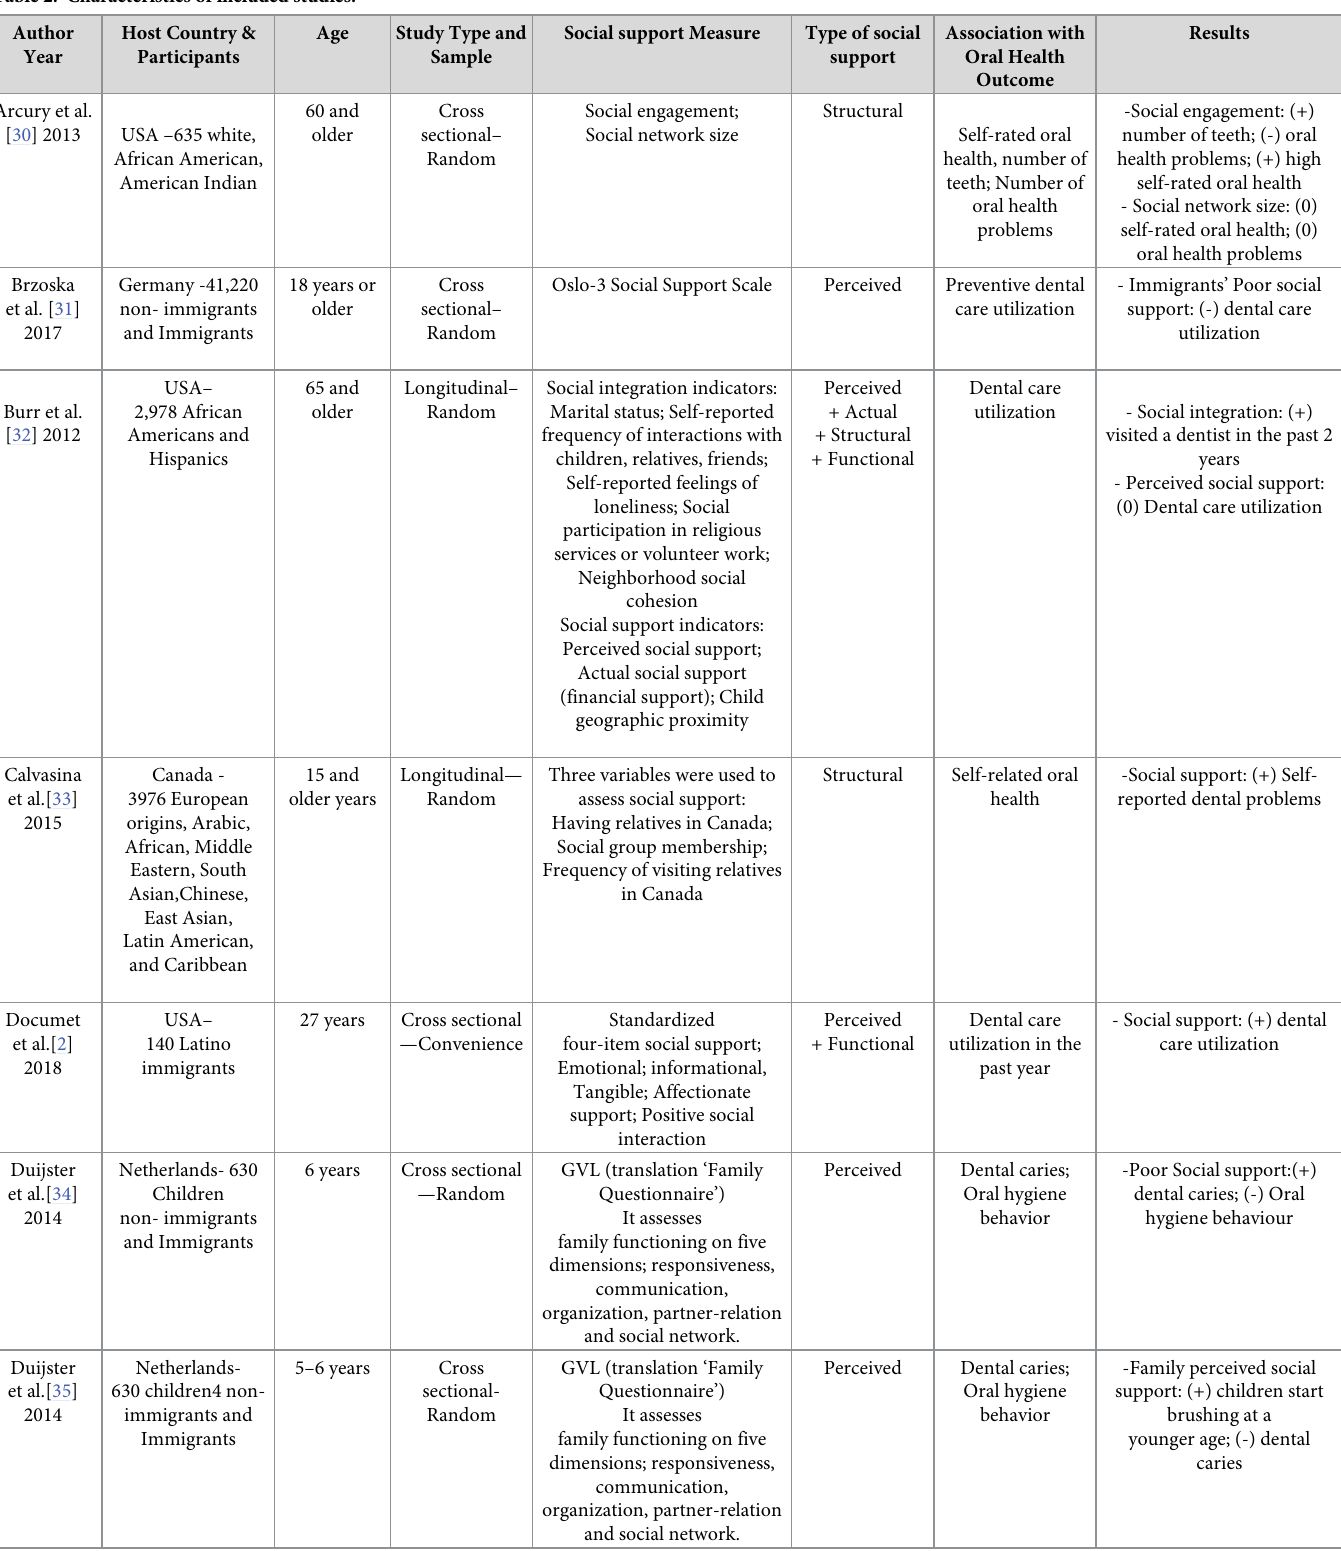
Table 2. Characteristics of included